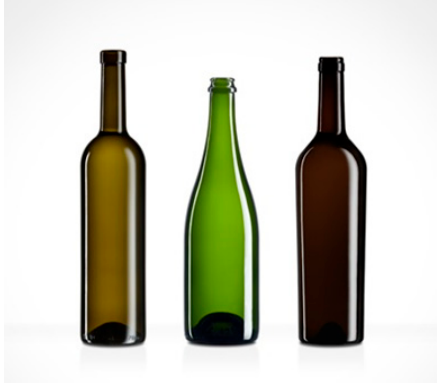
Figure 1. Examples of bottles of different shapes and